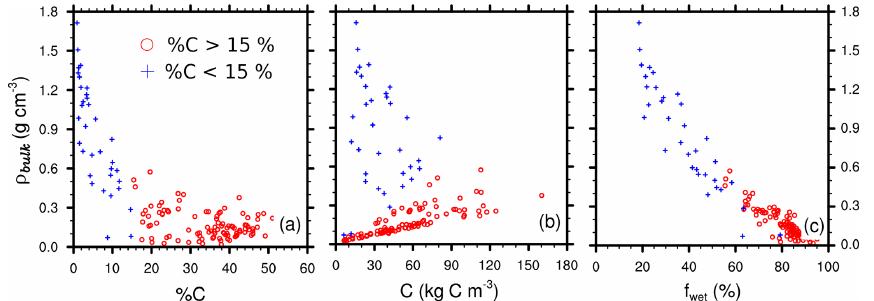
versus (a) soil carbon content f C (%), (b) soil carbon density ρ C (kgCm − 3 ), and (c) soil Figure 9. Scatter plots of soil bulk density ρ obs bulk water content (%) for the 135 samples. Red circles represent samples with carbon content exceeding 15% and blue crosses less than